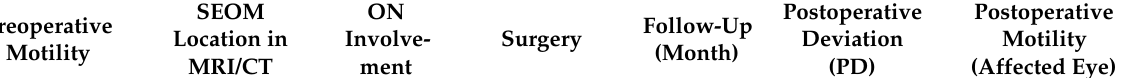
Table 1. Clinical characteristics and surgical results in 12 patients with supernumerary extraocular muscle.